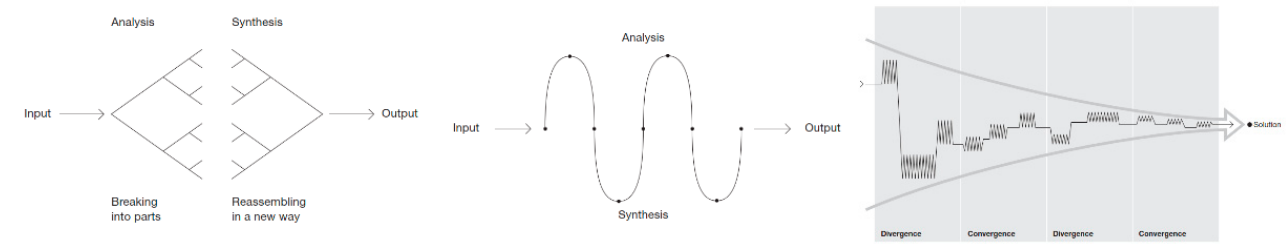
Figure 1. Design model schemes based on Christopher Alexander´s and Nigel Cross´s works [37].